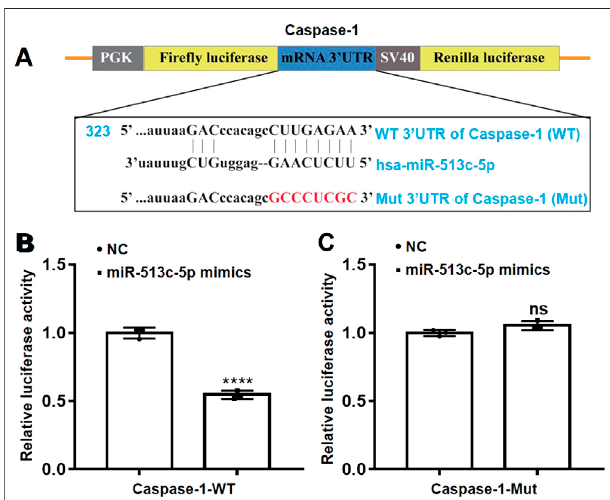
FIGURE 4 | miR-513c-5p targets caspase-1 mRNA 3 ′ UTR directly. (A) Schematicrepresentation ofcaspase-1mRNA3 ′ UTRdemonstratingputative miRNA target site, luciferase activities of WT and Mut constructs. (B,C) The luciferase activity was determined by co-transfecting the vectors (caspase-1 3 ′ UTR-WT or Mut) combined with NC, miR-513c-5p mimics into 293T cells, respectively. **** p < 0.0001.